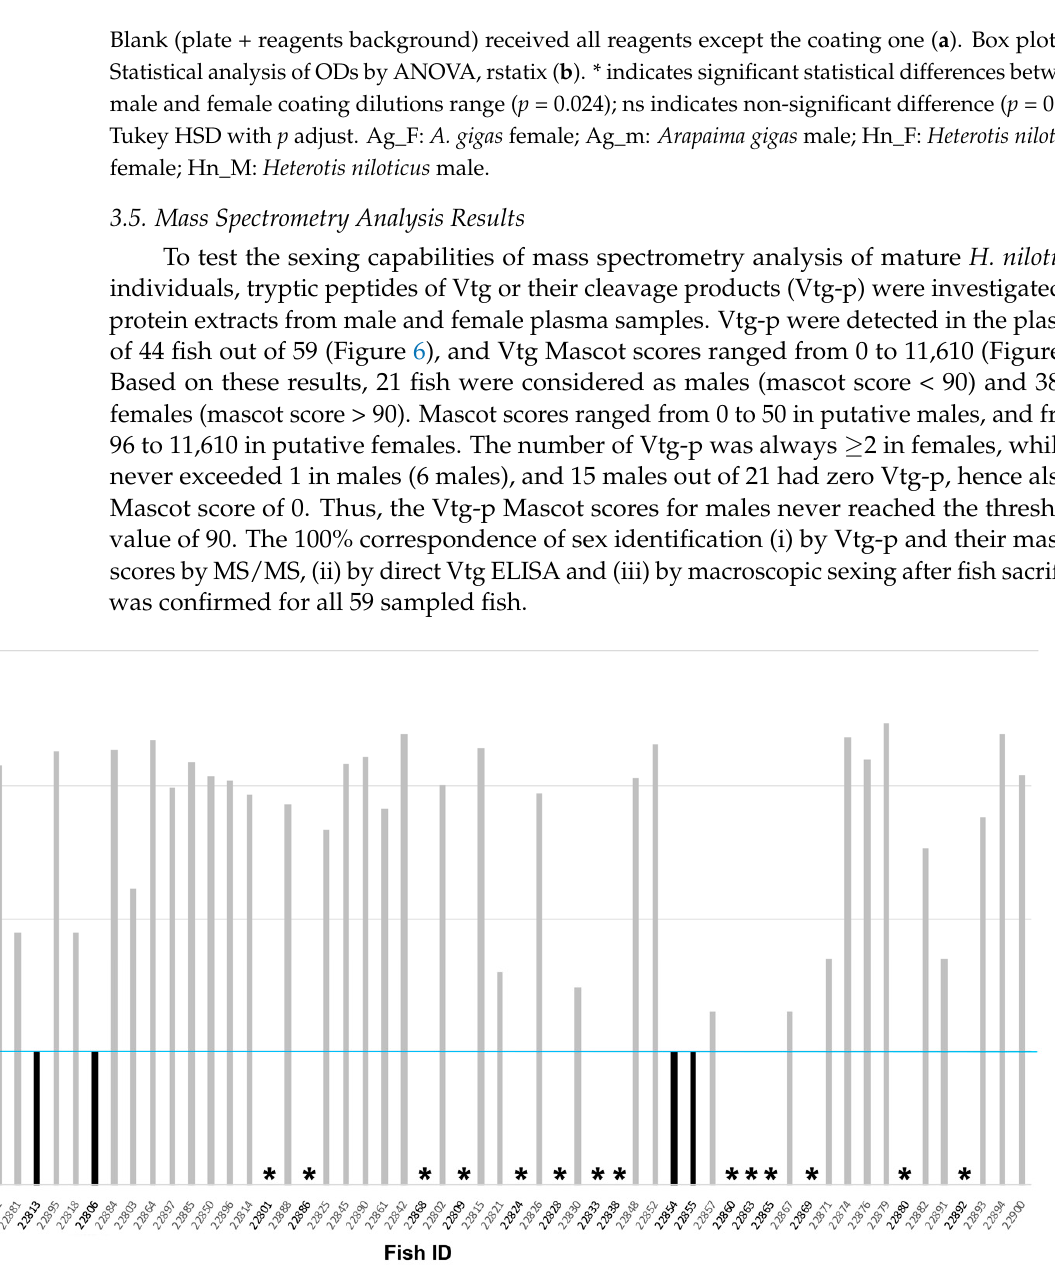
Figure 6. Detection of Vtg and Vtg cleavage products by mass spectrometry from plasma of sexually mature African bonytongue, Heterotis niloticus , (log-scale Y-axis). The fish with a number of Vtg- specific peptides ≥ 2 were considered as females (gray vertical bars), those with a number of Vtg- specific peptides = 0 (indicated by * for 15 out of 21 fish) or 1 (solid vertical bars for 6 out of 21 fish) were considered as males (bold IDs on X-axis). The male/female threshold value is represented as a blue line at number of Vtg tryptic peptides = 1.